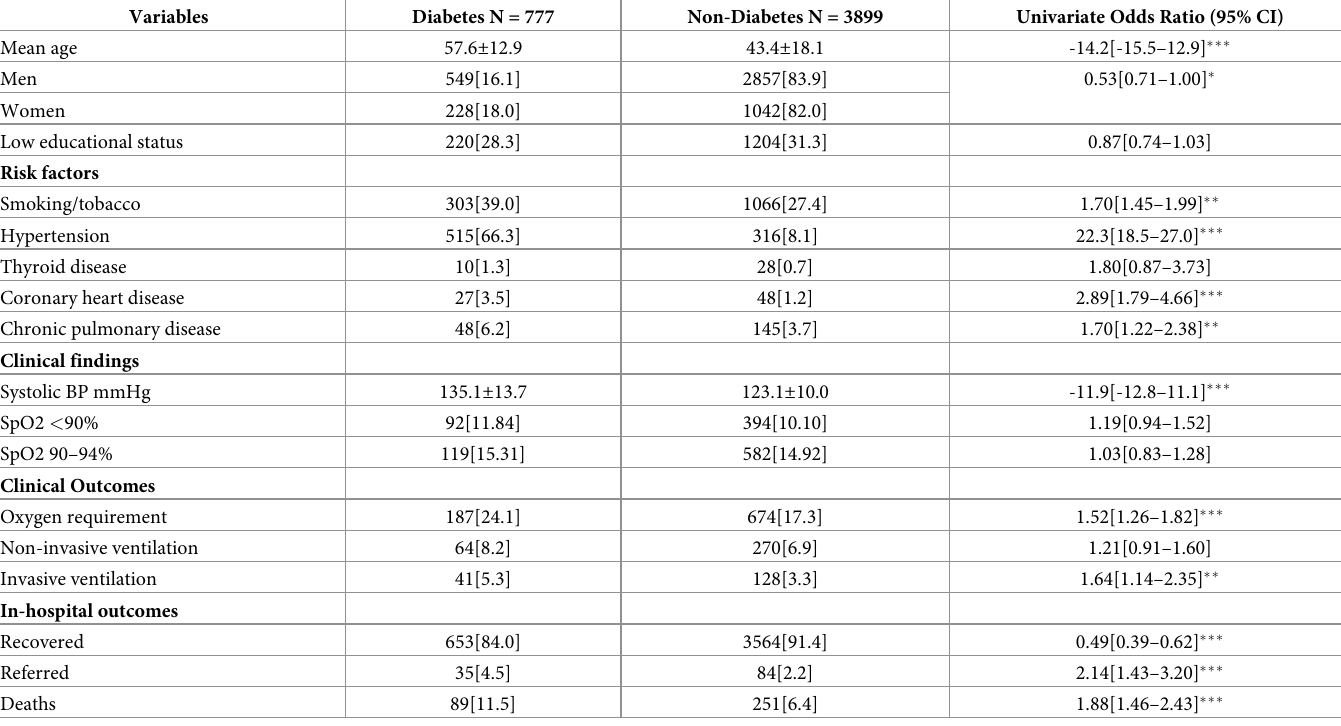
Table 4. Clinical characteristics and outcomes according to